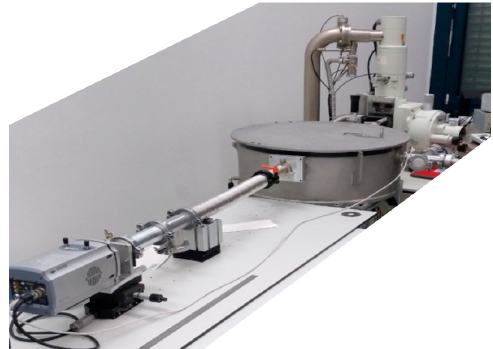
Figure 4. General view of the spectrometer. For the alignment, an ANDOR CCD camera was used.